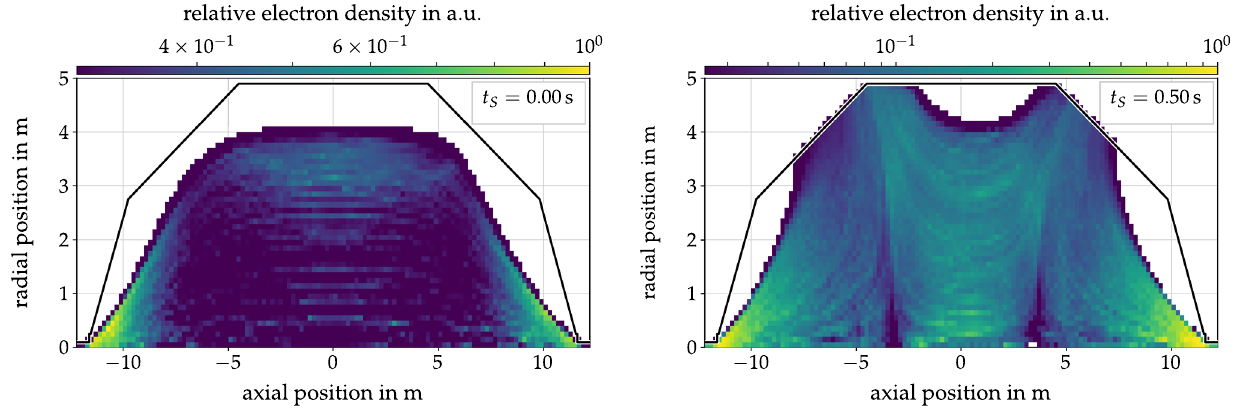
Fig. 10 Simulated electron density in the flux tube during a magnetic pulse. The plots show the density rotated around the spectrometer axis (axial symmetry). The black outline indicates the spectrometer walls with r max = 4 . 9 m. The electron density was determined by filling each step of the simulated electron trajectories into a two-dimensional ( r , z ) - histogram and weighting by Eq. (16). Left: the normalized density of low-energy electrons with E 0 = [ 0 . 1 ; 10 ] eV at nominal conditions